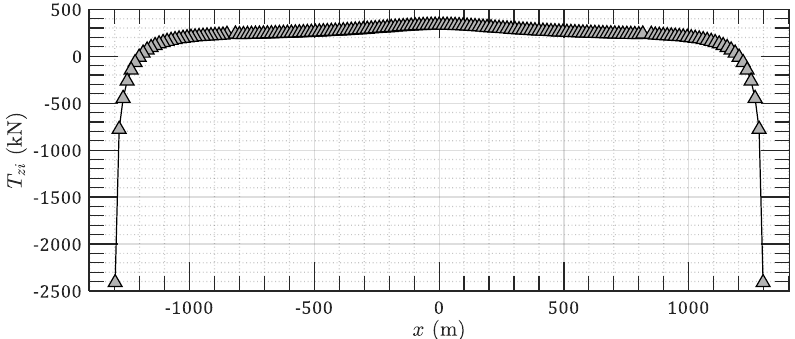
Figure 13. Hanger tension components in z-direction along the bridge span.